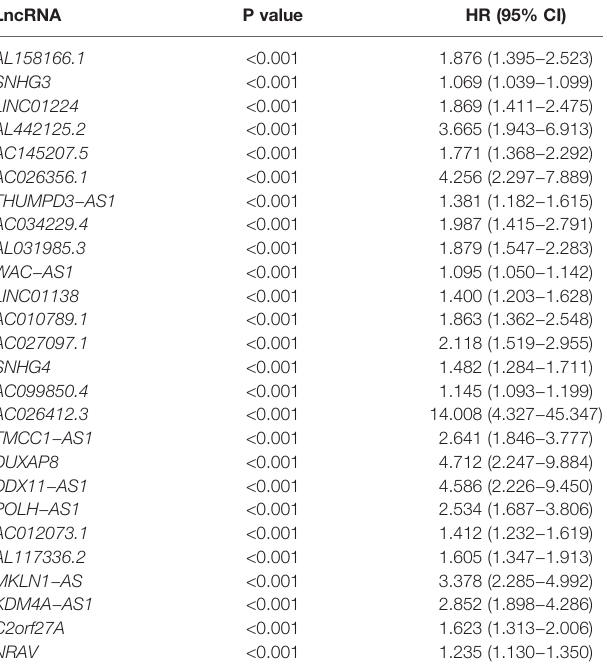
TABLE 1 | Identi fi cation of 26 prognosis-related lncRNAs by univariate analysis. LncRNA